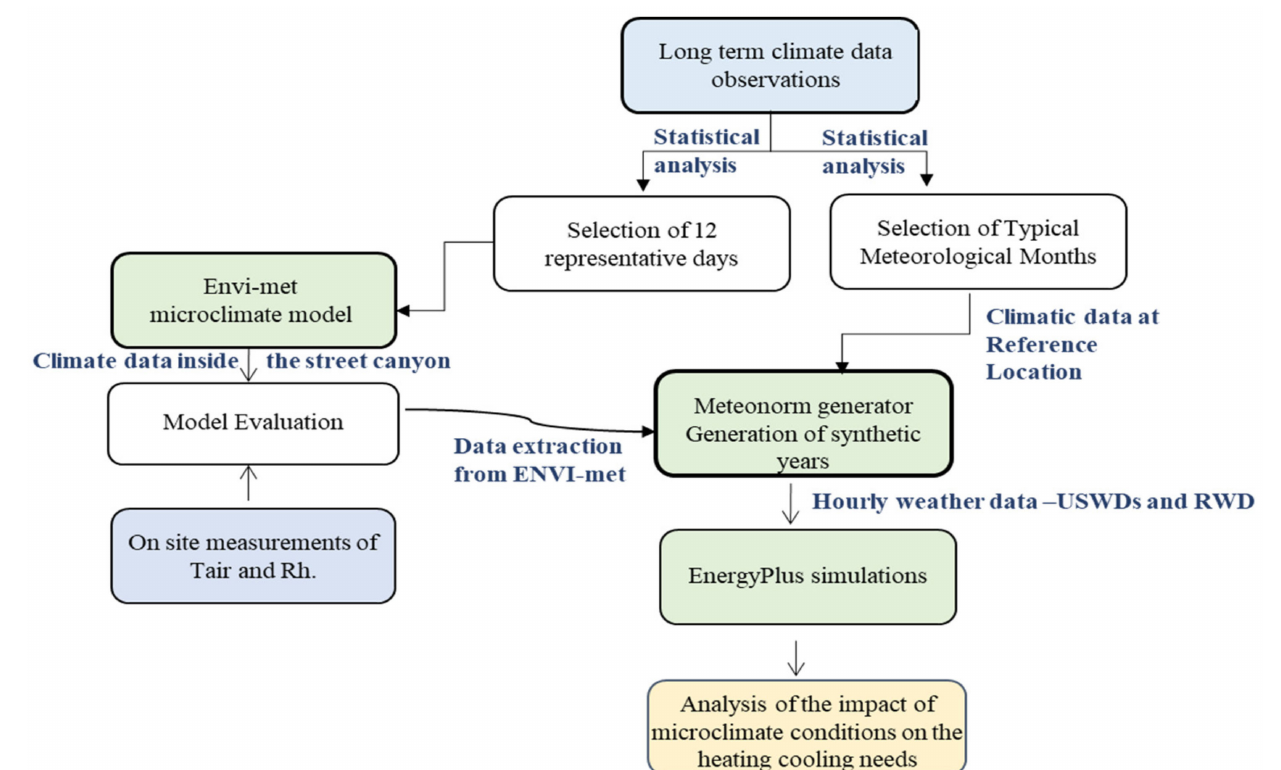
Figure 3. Flow chart of the implemented